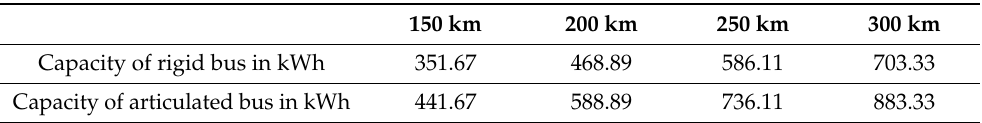
Table 1. Bus types used for the analysis with their range and battery capacity. Reprinted with permission from Ref. [4]. Copyright 2021, IEEE.